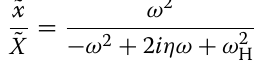
The mechanical eigenfrequencies of the mass-spring system are given by